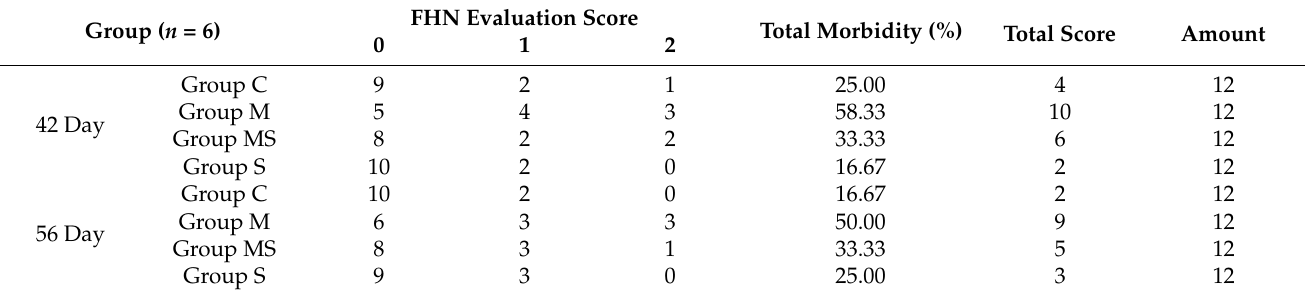
Table 1. FHN evaluation and morbidity in broilers, when both legs of each broiler were counted.